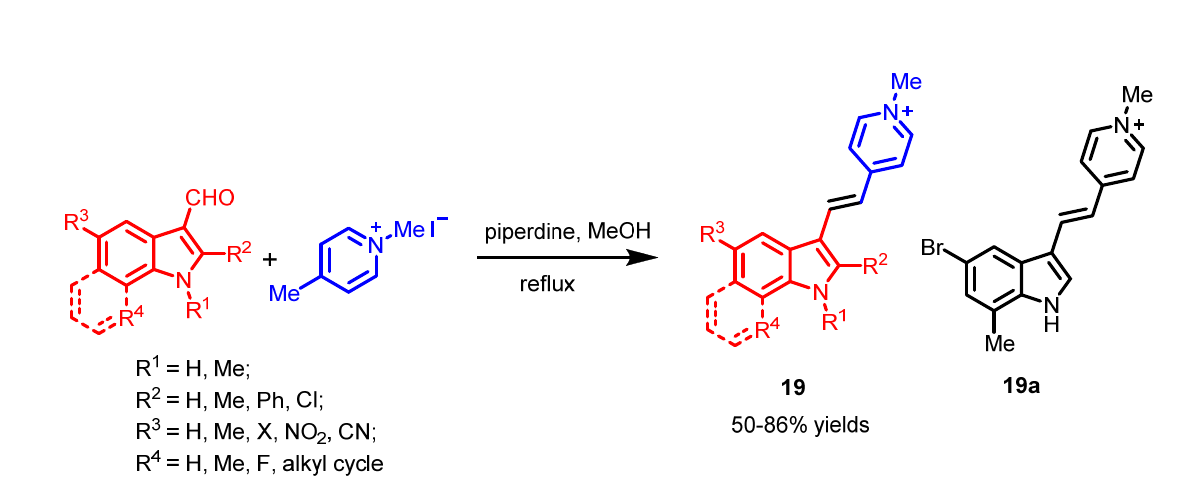
Scheme 15. Synthesis of F16s 19 and representative compound 19a .